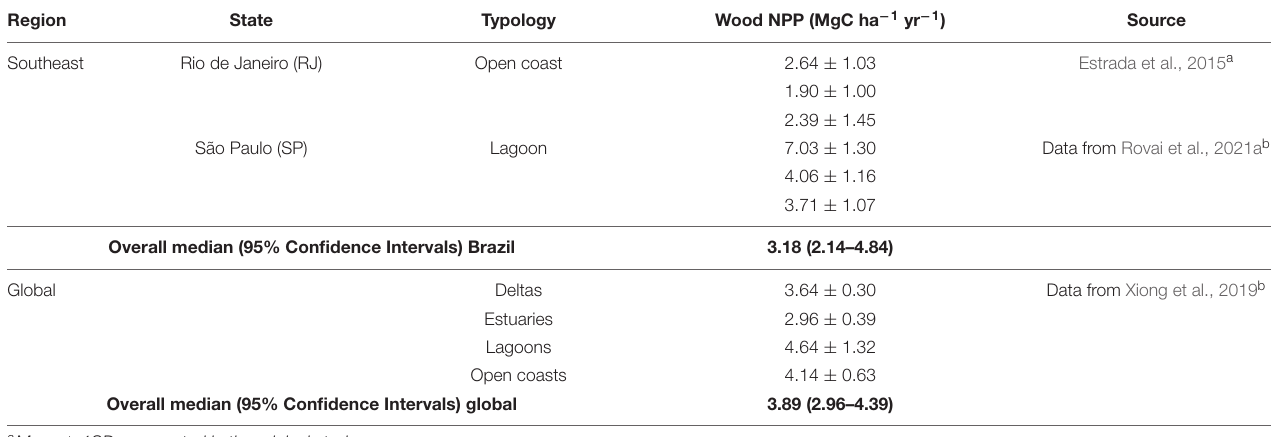
TABLE 3 | Carbon sequestration rates in woody biomass for Brazilian and global mangroves.